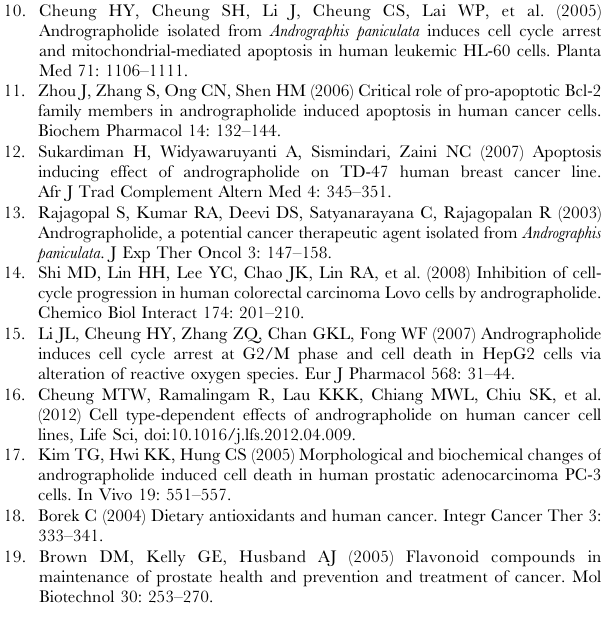
indicate round and loosely-attached cell and pink arrows indicated apoptotic body formation. Bar= 50 m m. Figure S2 Nuclear morphological change of DU145 cells treated with Andro. The cells were treated with Andro at different concentration for 48 or 72 hours; adherent cells and floating cells were stained by Hoechst 33342 and observed under fluorescence microscopy respectively. A) control, 48 h; (B) 20 m M Andro, 48 h, adherent cells; (C) 20 m M Andro, 72 h, adherent cells; (D) 20 m M Andro, 48 h, adherent cells; (E) 40 m M Andro, 72 h, adherent cells; (F, G) 40 m M Andro, 48 h, floating cells. Yellow arrows indicate nuclear condensation and red arrows indicate nuclear fragmentation. Bar= 50 m m. Figure S3 MAD2 depletion abrogates Taxi + Andro-in- duced mitotic block. DU145 cells were transfected with or without a MAD2-specific double-strand siRNA and then incubat- ed further for 24 h in DMEM before treatment with 20 m M Andro alone or 20 m M Andro and 100 m M Taxifolin or without any chemical for 24 h. After fixation, the cells were analyzed with flow cytometry for the population (in percentage) of mitotic cells (in boxes) with higher levels of phospho-histone H3 (at S10) and